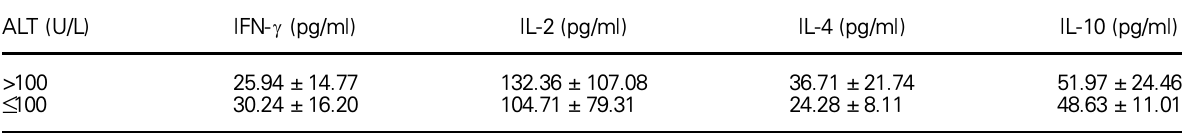
Table 3. The relation of cytokines and ALT in HCV infection